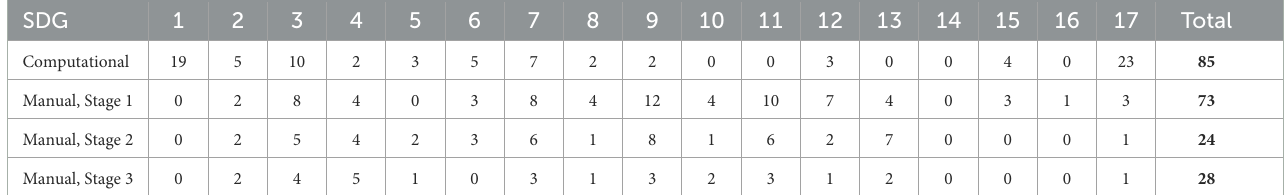
TABLE 4 Frequency of SDG occurrence for sustainability-focused modules/courses with high confidence from the computational technique and from the manual review of description (Stage 1), learning outcomes (Stage 2) and module aims (Stage 3).